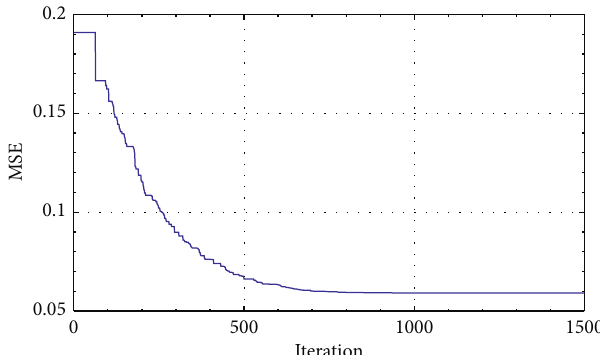
Figure 5: Mean squared error for the proposed RBFNN model.